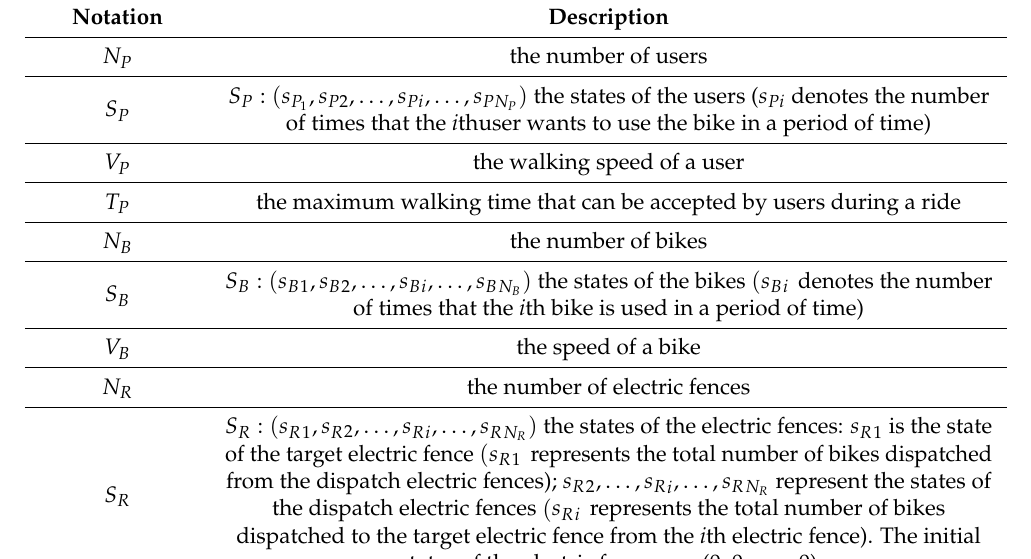
Table 1. The mathematical model of a bike sharing